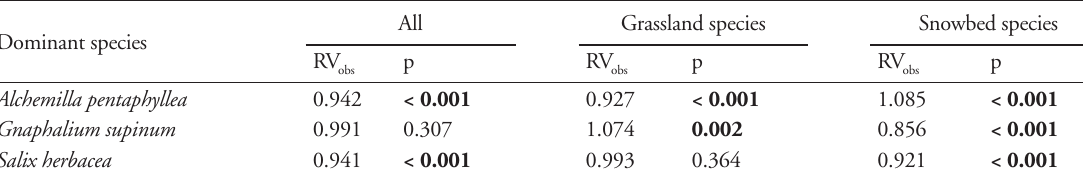
Table 3. Spatial relationships of dominant snowbed species with the remaining vegetation (All), and the two opponent groups of spe- cies (alpine grassland species and subordinate snowbed species), respectively. Spatial patterns were detected by calculating the observed variance ratio (RV ) and comparison to the null model with randomly distributed species. A value of RV = 1 means a random obs obs distribution of species, values of RV < 1 suggest segregation, RV > 1 indicate aggregation. Significant p-values at < 0.05 in bold. obs obs n = 480 circles.